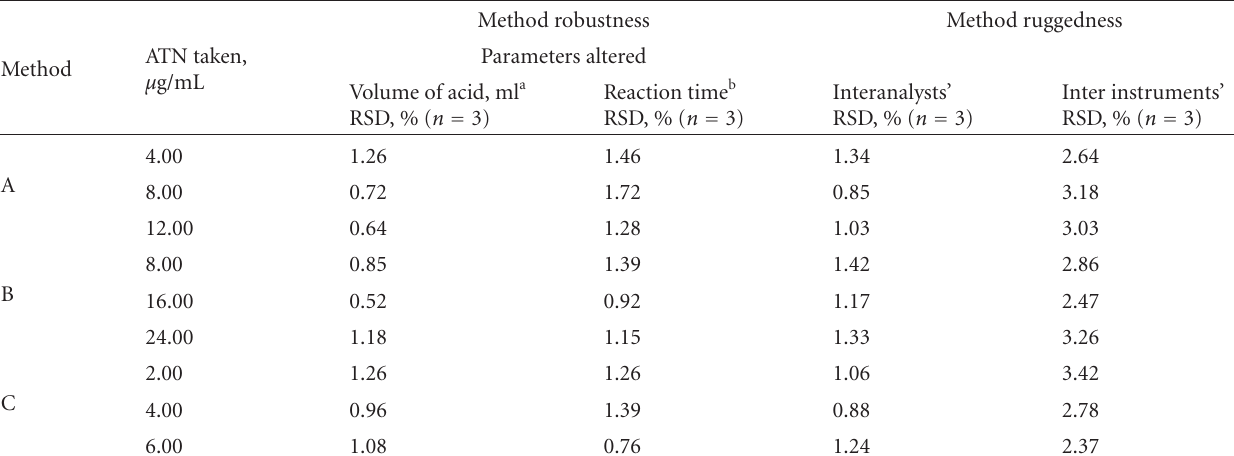
Table 4: Robustness and ruggedness.